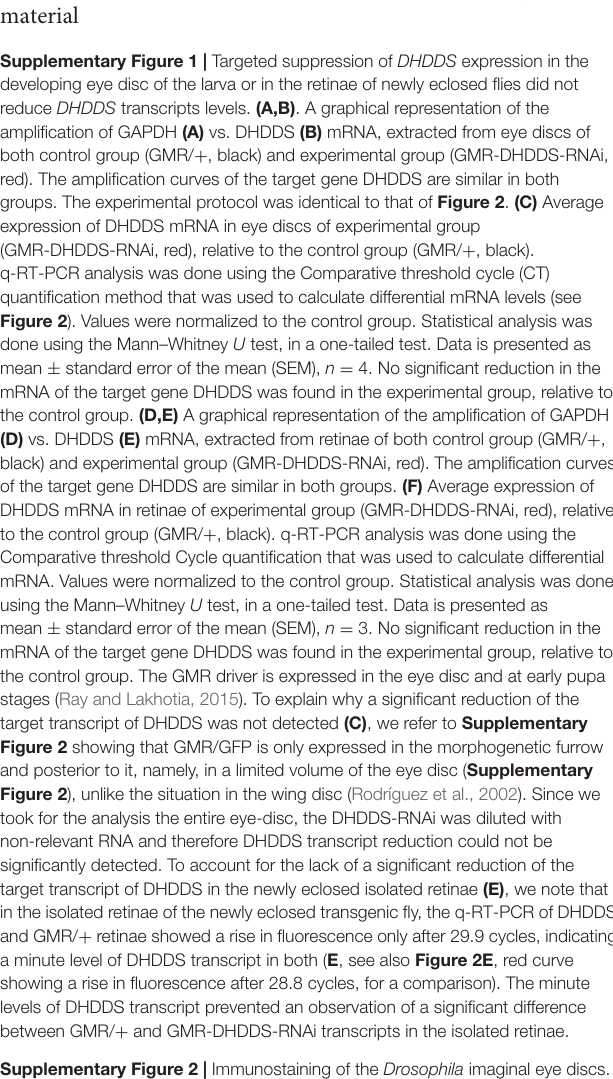
Supplementary Figure 2 | Immunostaining of the Drosophila imaginal eye discs. Eye discs of GMR-Gal4/GFP (GMR/GFP) late third instar larvae were collected